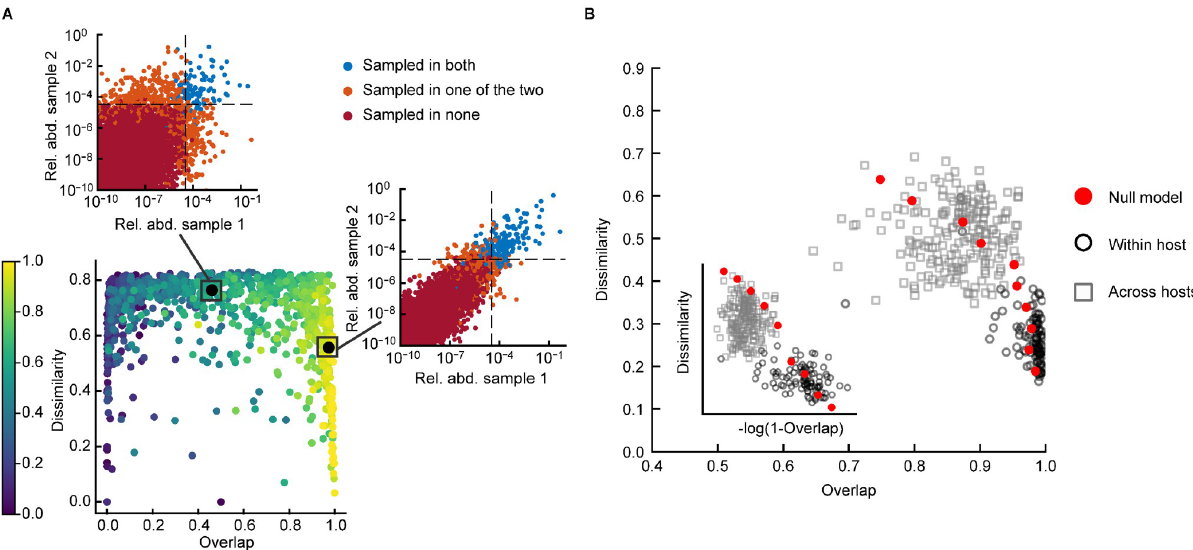
Fig 4. Overlap-Dissimilarity curves in the model and in empirical data. A) Relationship between Overlap and Dissimilarity for communities of the values of K of the community pair, ranging from 0.6 to 1. The generated with the model. The color of the circles corresponds to the correlation ρ k two insets show scatter plots of the abundances in two pairs of communities, one with a high ρ k and one with a low ρ k . Blue circles represent OTUs sampled in both communities, orange circles OTUs sampled in only one community, and red circles OTUs sampled in neither. The dotted lines mark 1/ N . B) Relationship between overlap and dissimilarity in empirical data (black circles: samples from the same hosts, grey squares: samples from reads different hosts) and according to the model (red circles, binned average of model prediction). The inset shows the same plot with a logarithmic scale on the x axis. For the main plot, the binned average of the model prediction is performed along the y axis, to better capture the pattern at high overlap values.